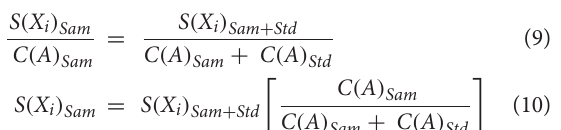
amount of sample, m will have the same value in both Equations (7) and (8), which may then be combined (Equation 9), and rearranged to give Equation (10).